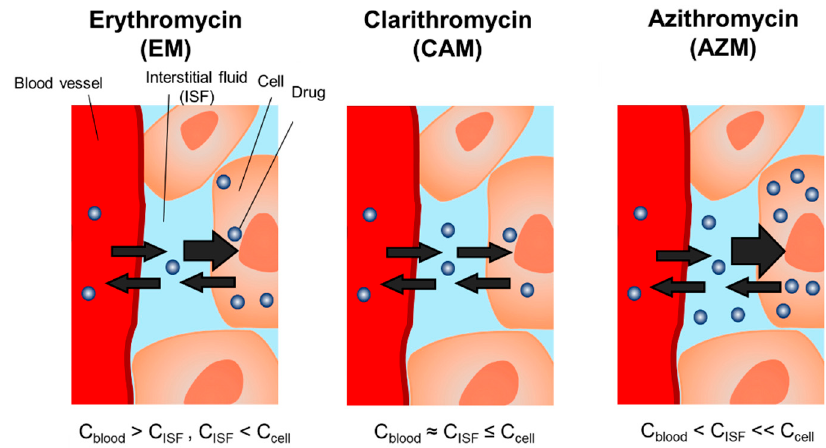
Figure 4. Schematic of transport of three macrolides from blood circulation into extravascular space. C blood , drug concentration in blood; C ISF , drug concentration in the interstitial fluid; C cell , drug concentration in the cell.